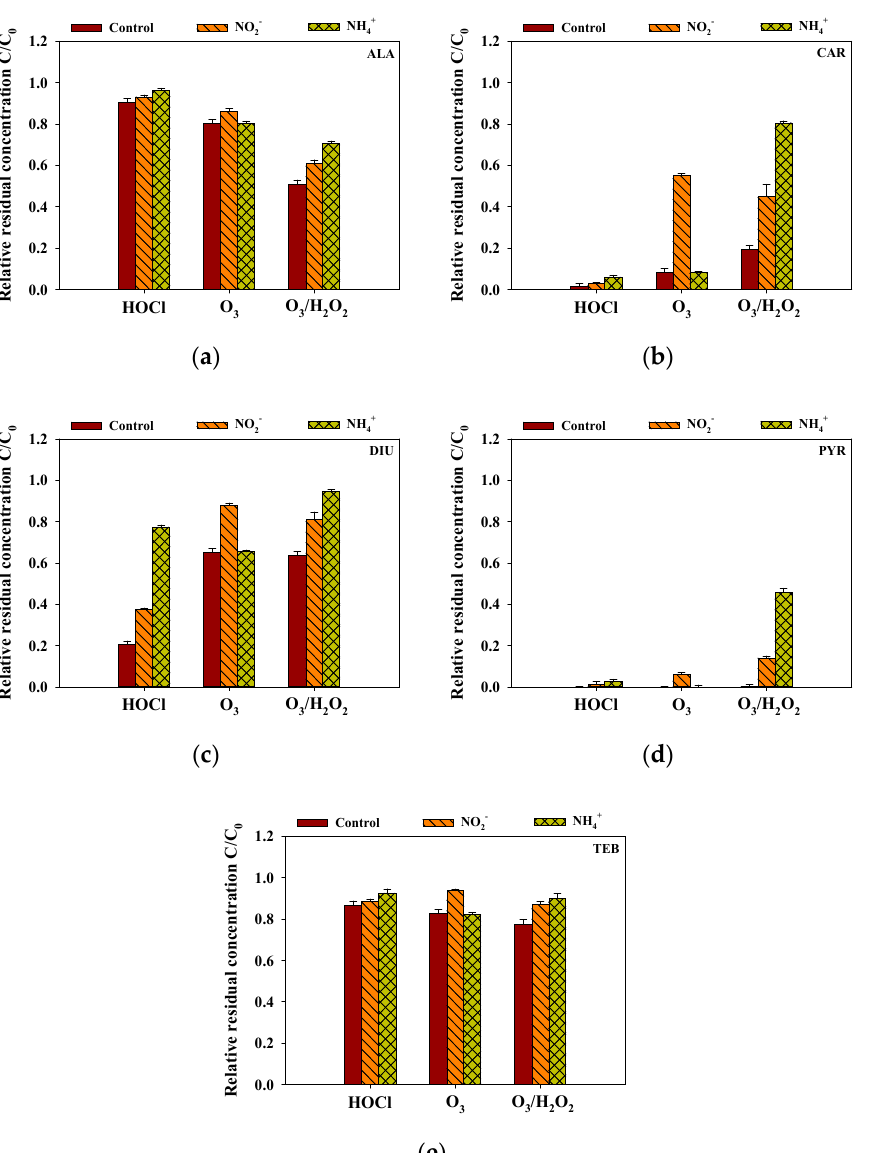
Figure 5. The effects of inorganic matter on the removal efficiencies of ( a ) ALA, ( b ) CAR, ( c ) DIU, ( d ) PYR and ( e ) TEB by HOCl, O 3 , and O 3 /H 2 O 2 (initial concentration of each pesticide = 2 μ M, the concentration of each inorganic matter = 4 mg/L, reaction time = 0.5 h, temperature = 25 °C, pH = 6.6).